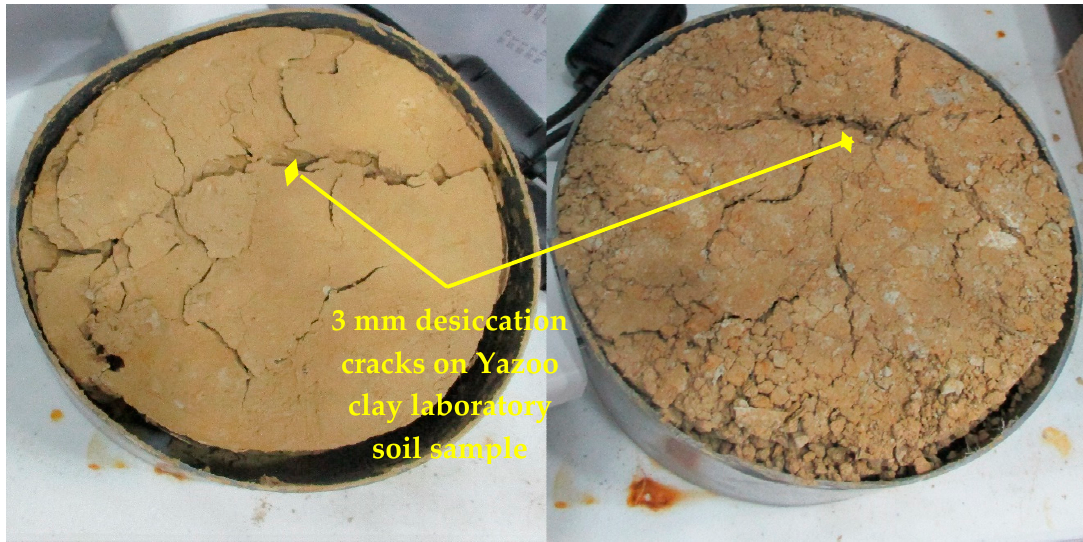
Figure 8. Desiccation cracks on Yazoo clay soil observed at the laboratory.